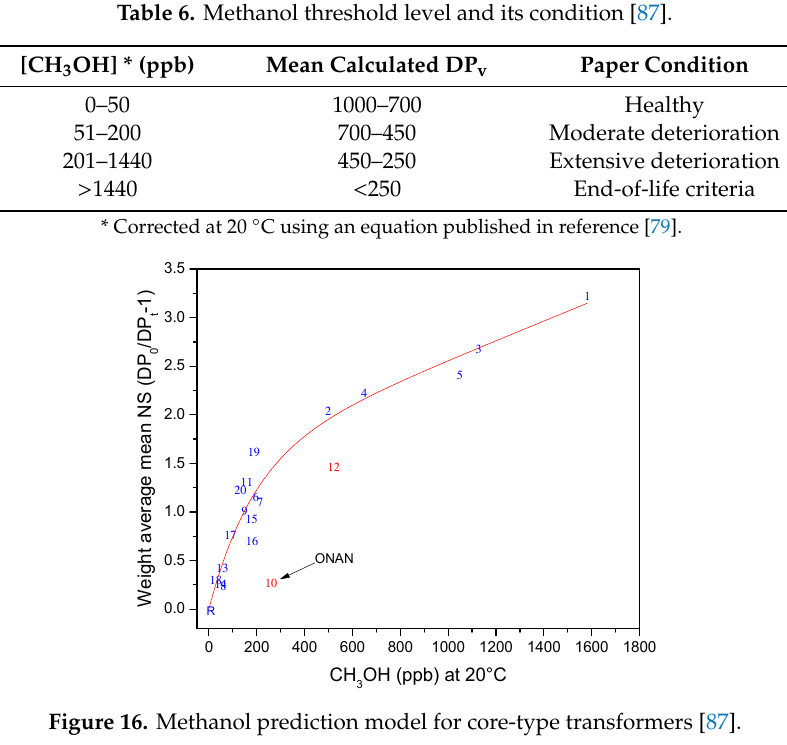
Table 6. Methanol threshold level and its condition [87] .